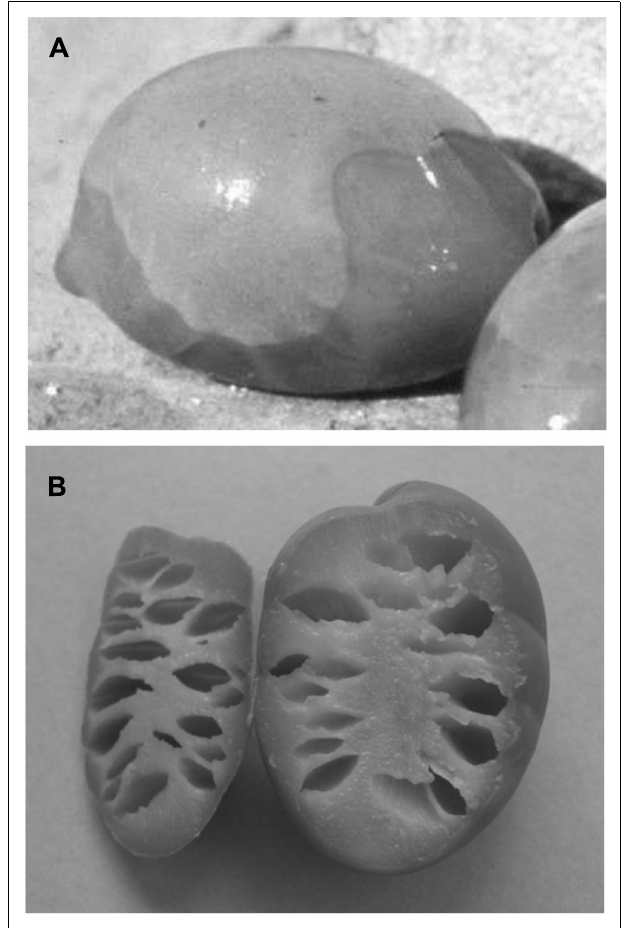
FIGURE 1 | Olive fruit showing hypocuticular (A) and intramesocarpic (B)